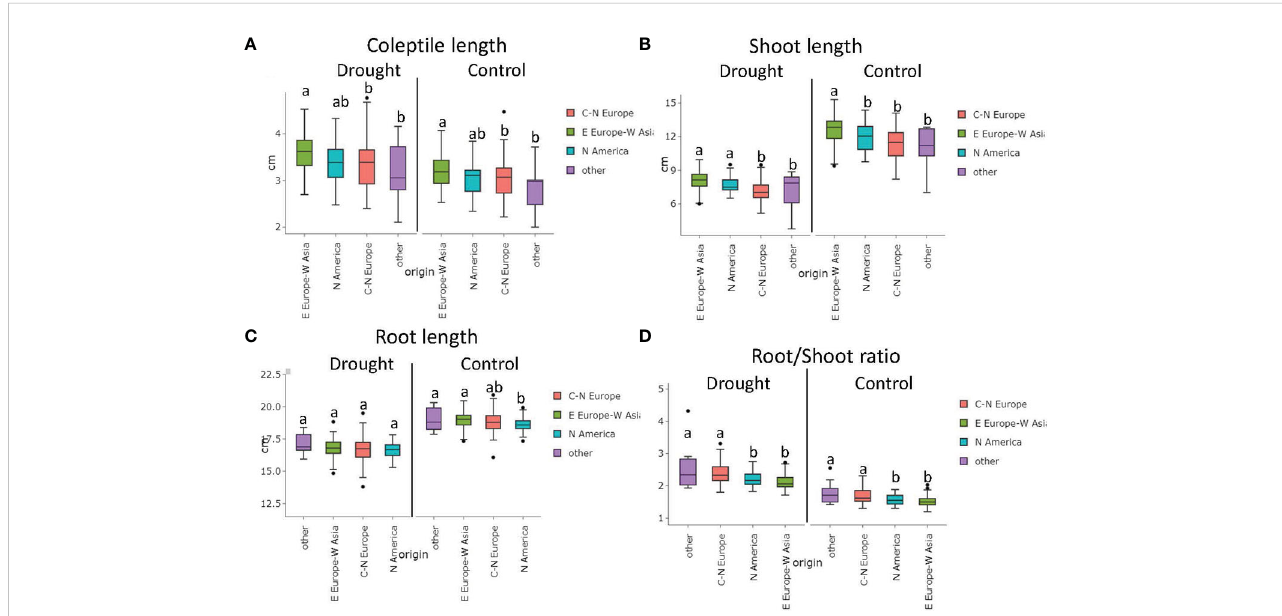
FIGURE 3 Variation on seedlings Coleoptile length (A) , Shoot length (B) , Root length (C) , and Root/Shoot Ratio (D) under control and drought stress based on genotype origin (BLUEs values). C-N Europe (Central-Northern Europe); E Europe- W Asia (Eastern Europe-Western Asia); N America (North America). Matching letters at thesame treatment are not statistically different (LSD p ≤ 0.05).